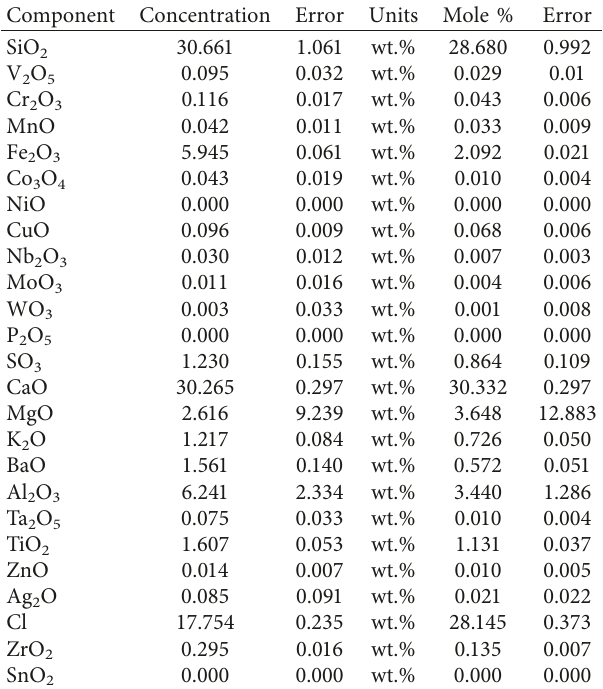
Table 3: XRF element result for lime characterization. Table 4: XRF result for contaminated soil